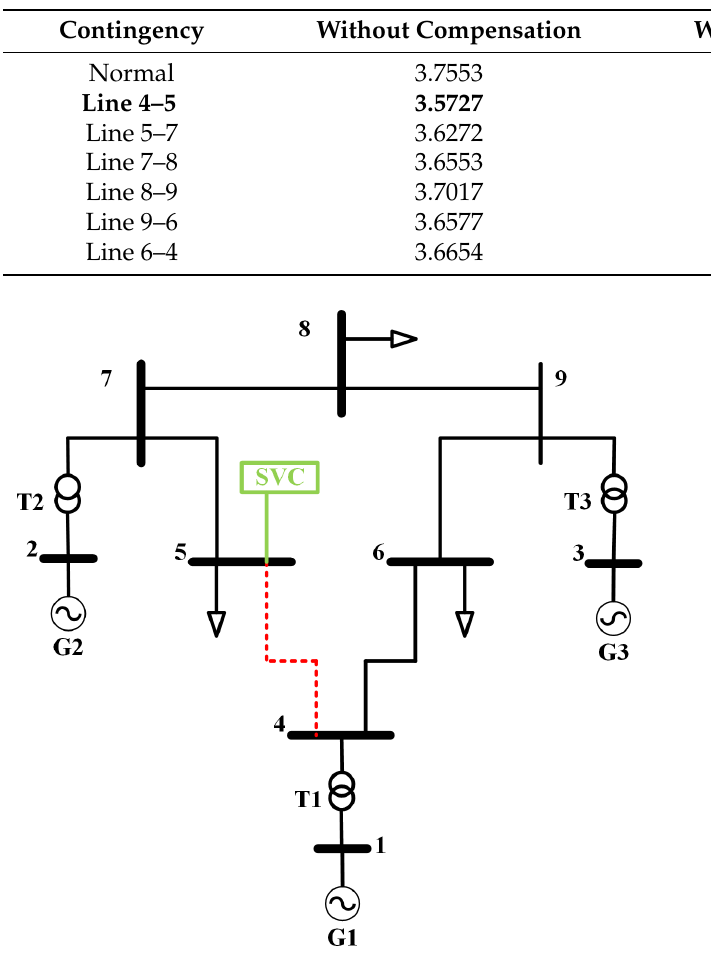
Figure 1. SVC location in the 9-bus bar IEEE